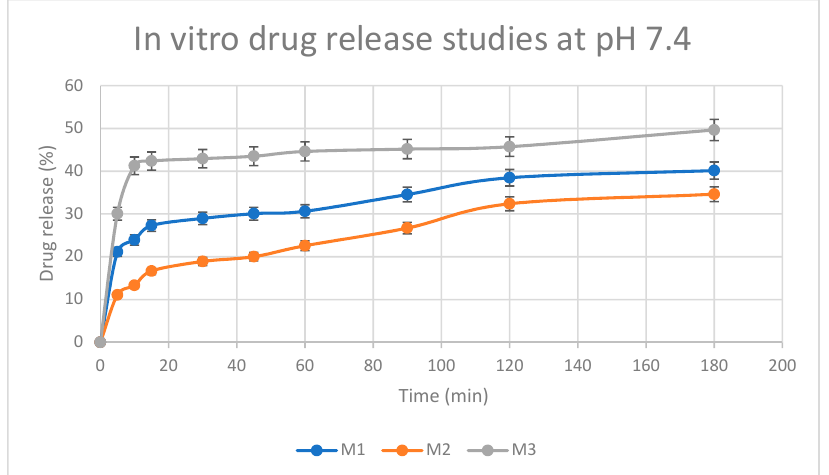
Figure 12. Release profile of 5-FU incorporated in chitosan–BTC hydrogels (M1, M2, and M3) investigated in phosphate-buffered saline (PBS) medium, pH 7.4. Results represent mean values ± SD; n = 3 (For M1 and M2: p > 0.05; M1 and M3: p < 0.05). At pH 6.5, rapid release of the drug occurs from 0 to 5 min, and then the drug is